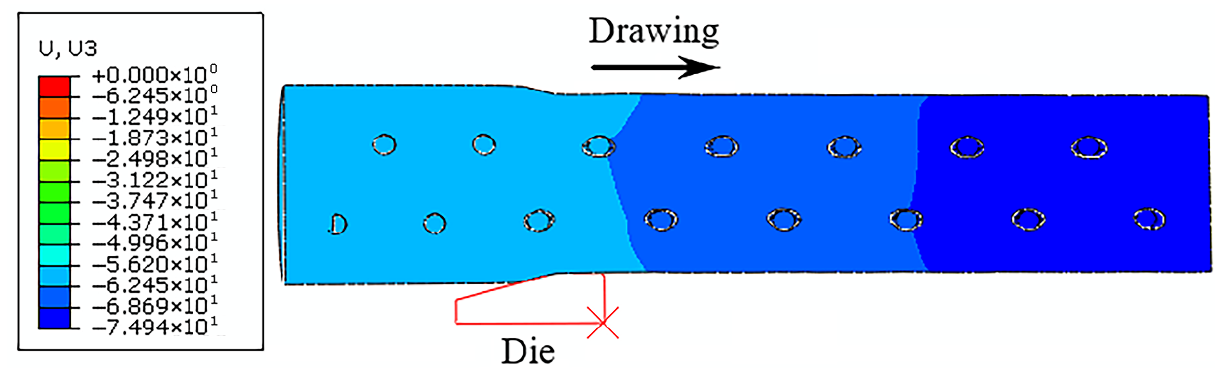
Figure 6. Strain distribution in drawing.